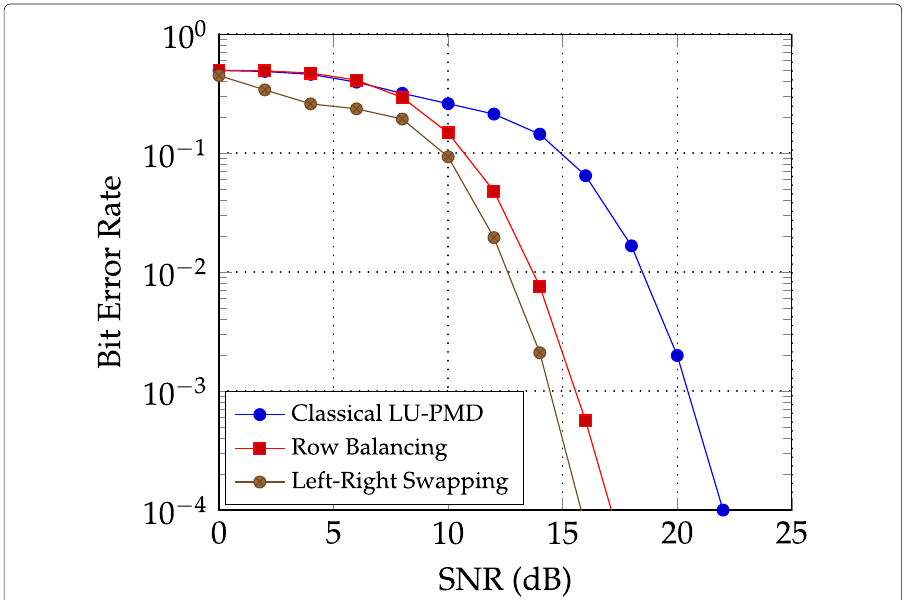
Fig. 5 BER comparison of the two beamformers: indoor ITU channel model